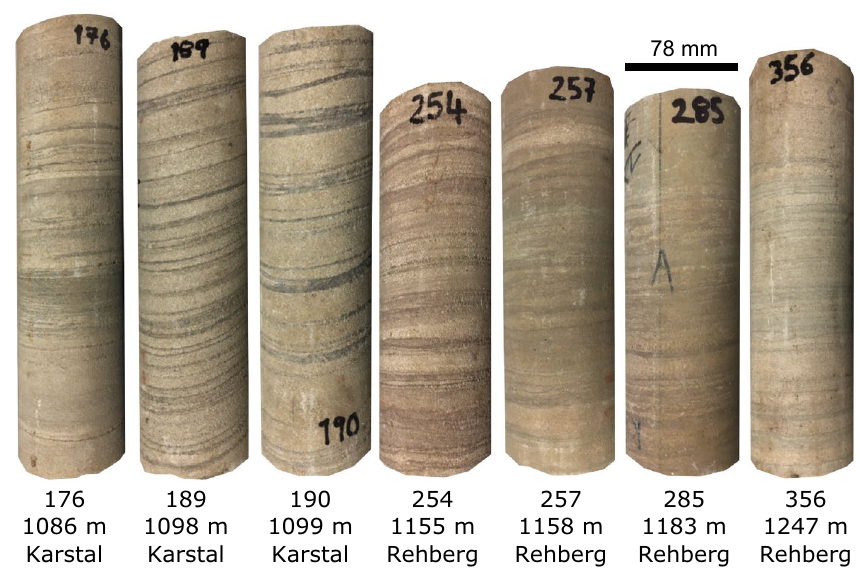
Fig. 3 Photographs of the visibility anisotropic 78-mm-diameter cores sampled from exploration borehole EPS-1 (Soultz-sous-Forêts). The box number, depth, and lithostratigraphic unit are provided next to each